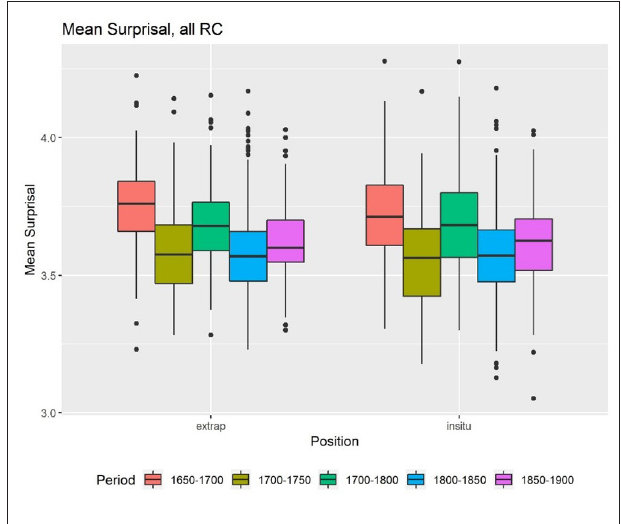
FIGURE 1 | Cumulative surprisal. FIGURE 2 | Mean